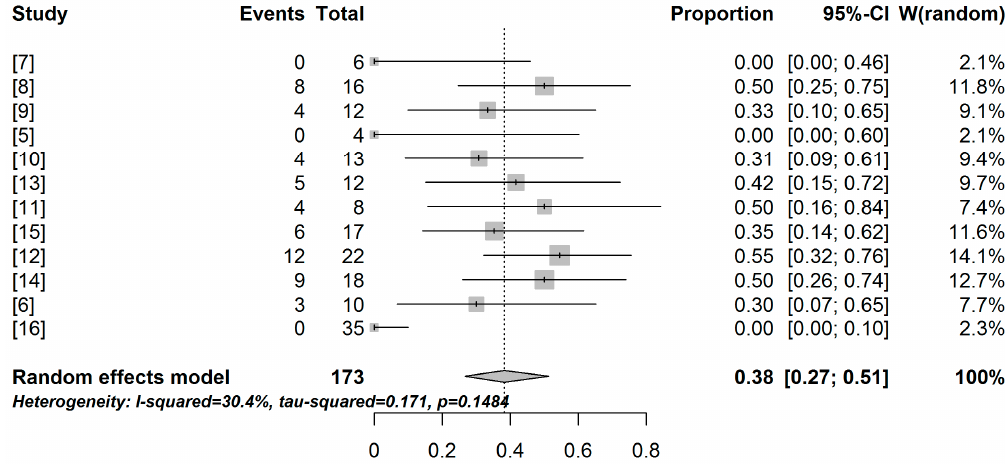
Figure 3. Forest plot of dendritic cell-based experimental anti-HIV-1 vaccines treatment success rate across studies. Each line represents a vaccination experimental protocol with the number of partial/transient responses to the vaccine (events column) among the vaccinated individuals (total column). The proportion of response to the vaccine is represented by a small vertical line inside a square. Each square is directly proportional to the sample size of each study, and the lines represent the 95% confidence interval. The proportions and confidence intervals are also represented in the column of the same name. The weight column (W(random)) represents how much each study contributed to the pooled sample size ( n = 173 individuals). The pooled proportion and 95% confidence interval estimated by a random effects model meta-analysis is represented by a diamond and highlighted in bold in the lower part of the figure. Heterogeneity measures (I 2 , τ 2 ) and the p -value of the Cochran’s Q test for heterogeneity are also represented.